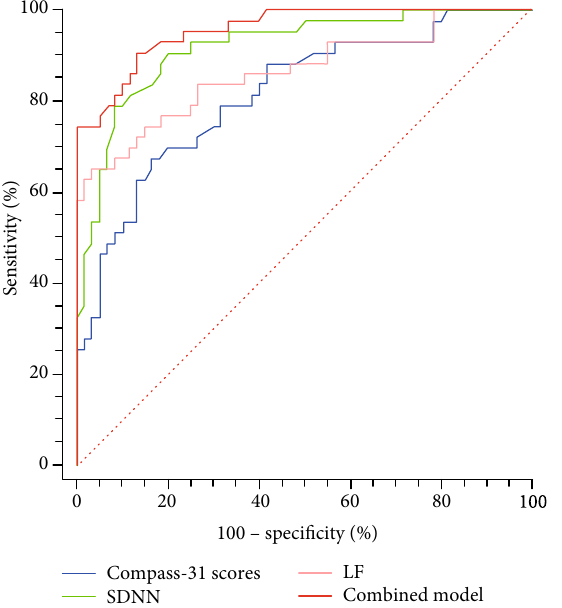
Figure 1: ROC curves comparing the ability of di ff erent variables and the combined model in distinguishing between participants with and without CAN. Combined model: the combination of COMPASS 31 score, SDNN, and